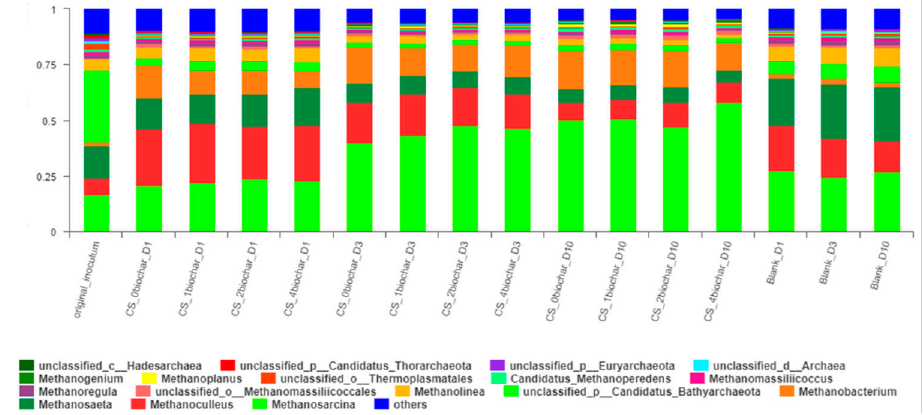
Figure 5. Taxonomic distribution of archaea at genus level.